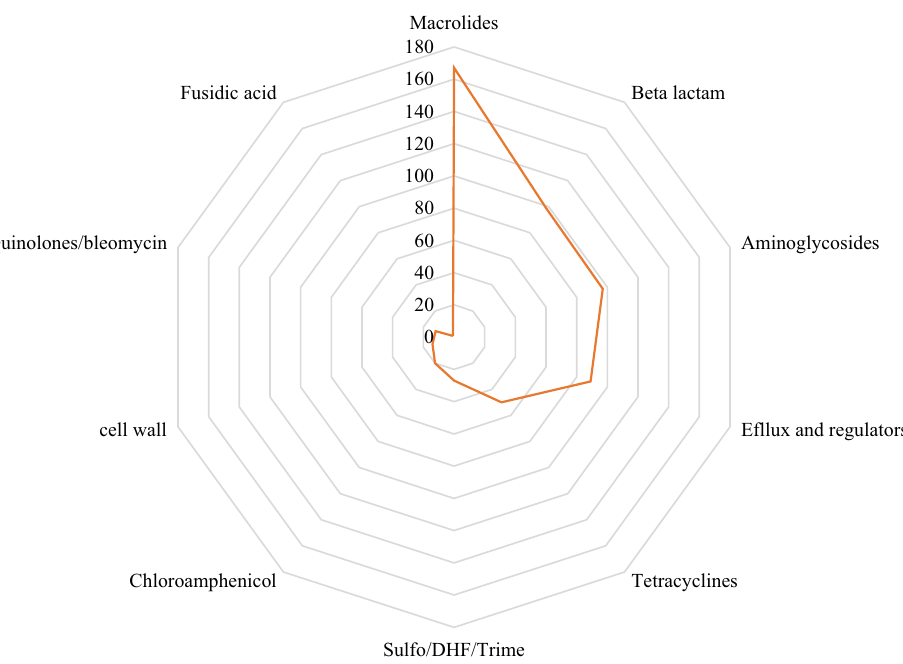
Figure 7. Antibiotic Resistant gene distribution across all wards of 26 mobile phones.